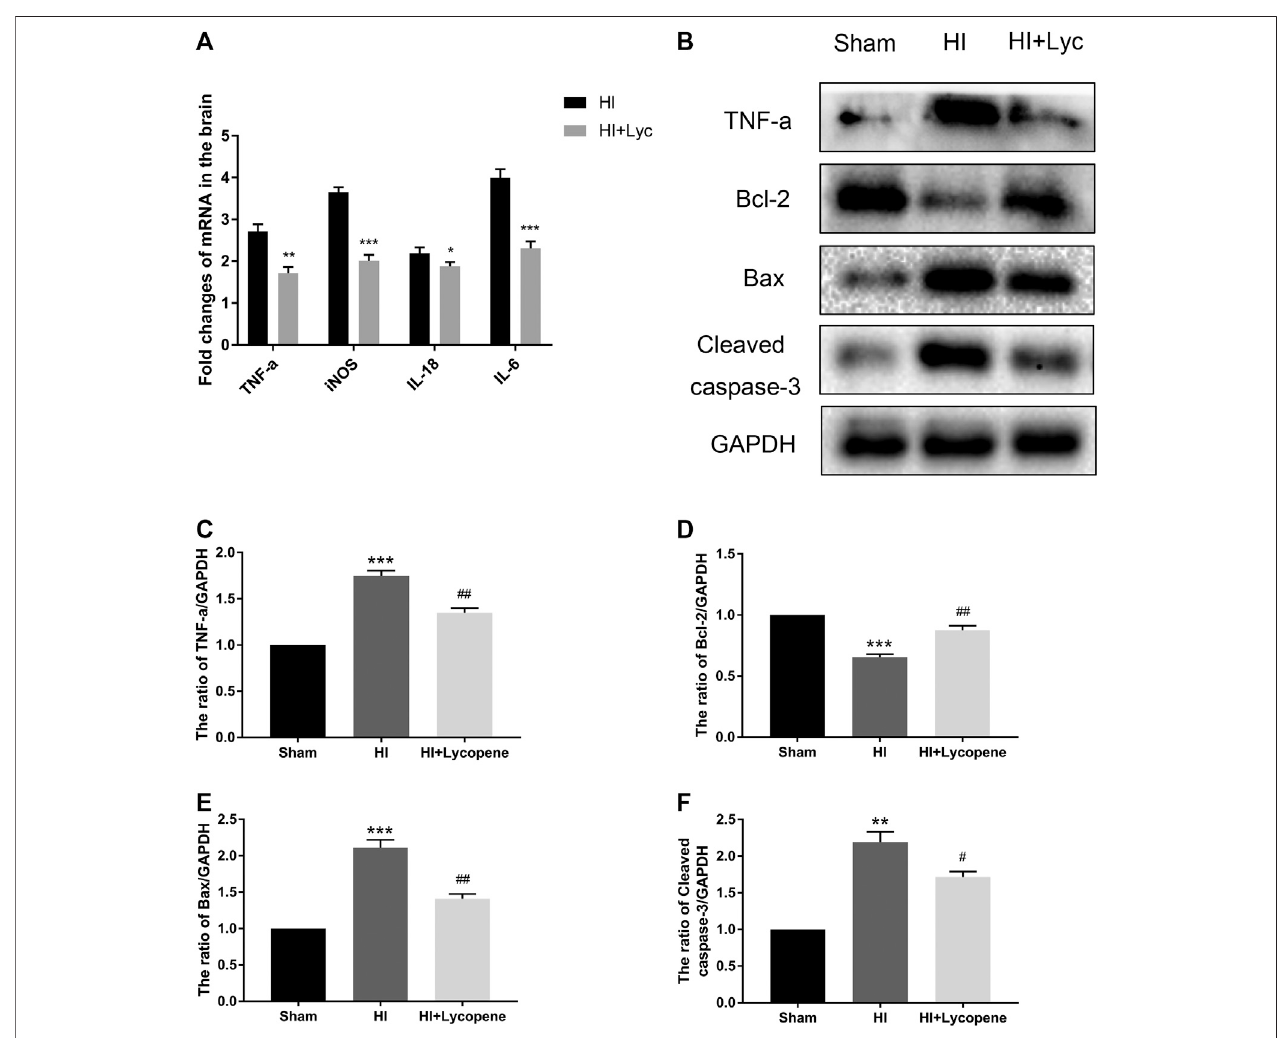
FIGURE2 | Treatment with Lycopene (Lyc) down-regulatedthe in fl ammatory response and apoptosis factors expression after hypoxic-ischemic (HI) brain injury in neonatal rats. (A) The mRNA expression oftumor necrosis factor α (TNF- α ), interleukin (IL)-18, IL-6 and inducible nitric oxide synthase in brain tissues 24 h after HI injury normalized to those of GAPDH for each sample. (B) The protein levels of TNF- α , Bcl-2, Bax and Cleaved caspase-3 were evaluated by Western blot 24 h after HI injury. (C – F) Quantitative analysis of the protein levels of TNF- α , Bcl-2, Bax and Cleaved caspase-3 based on Western blot results. ** p < 0.01 and *** p < 0.001 vs. the sham group; # p < 0.05 and ## p < 0.01 vs. the HI group. All data are presented as mean ± SEM, n (cid:2)